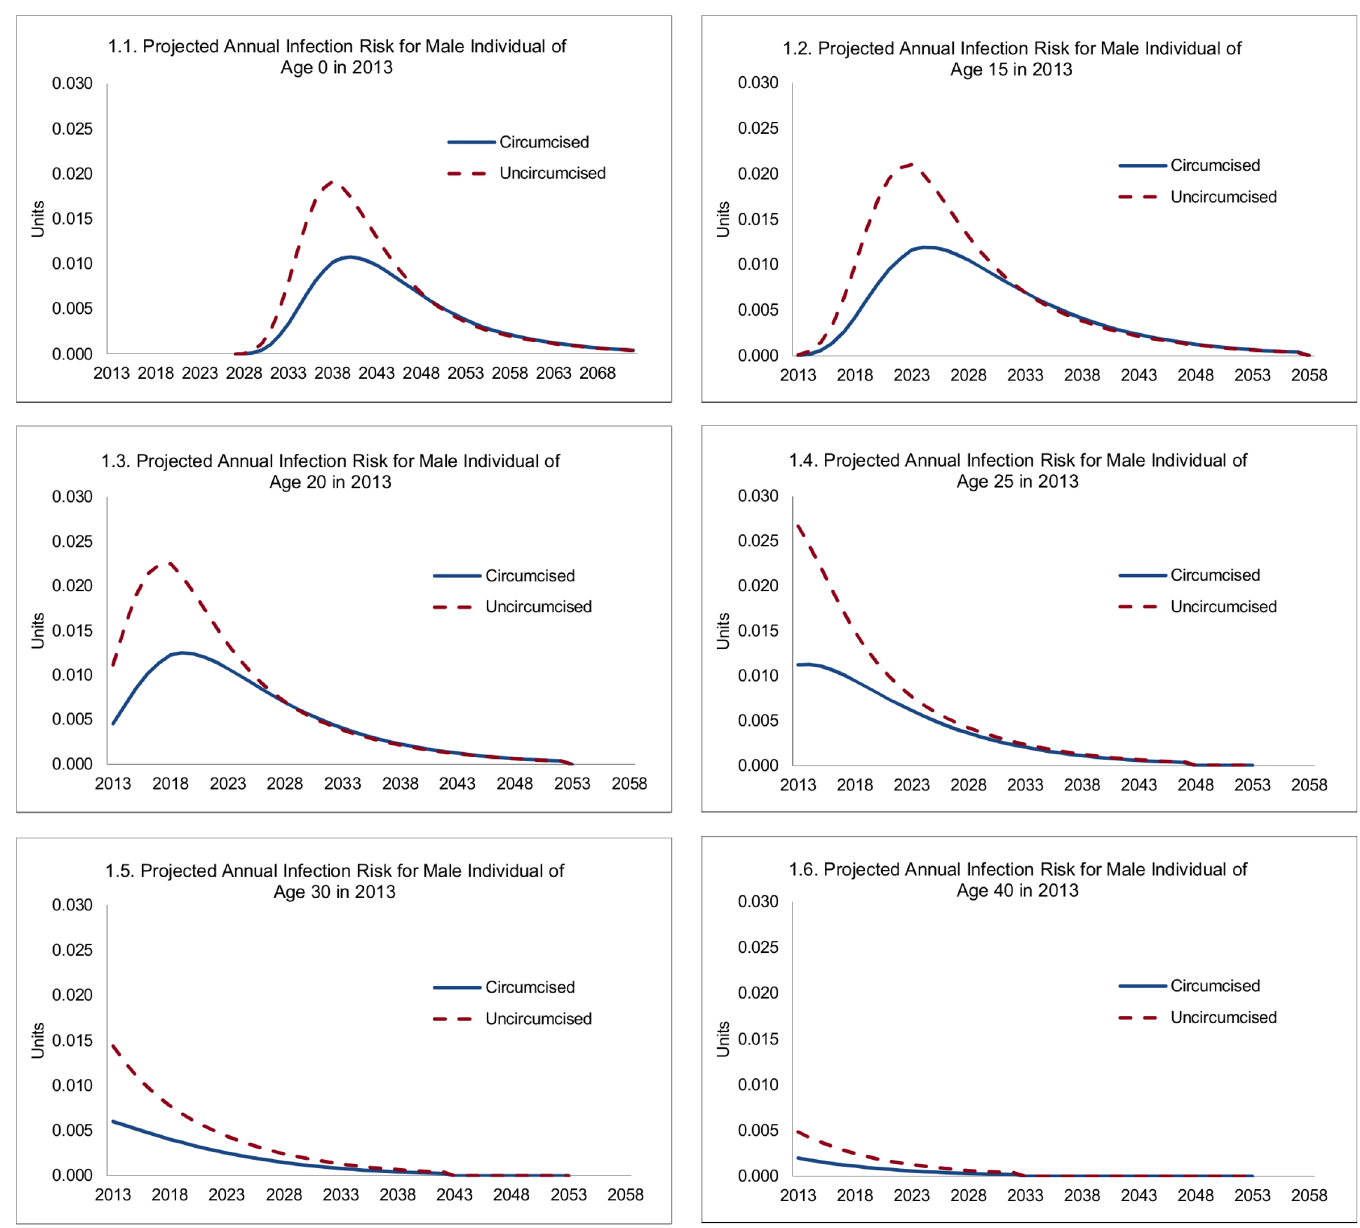
Fig 1. Projected annual infection risk for male individual, by